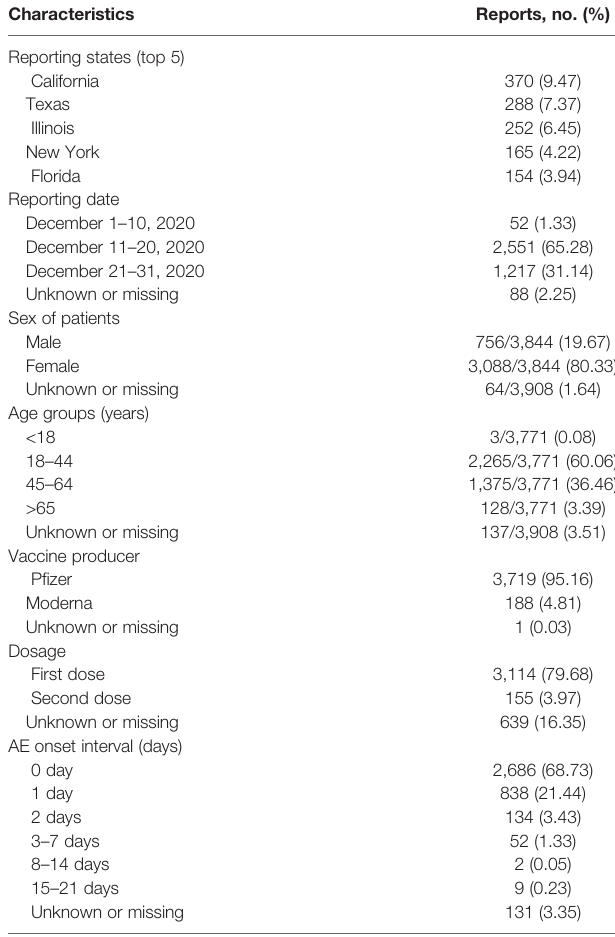
TABLE 1 | Demographic characteristics and vaccine information of cases with AEs after COVID-19 vaccine reported to VAERS database in December 2020.